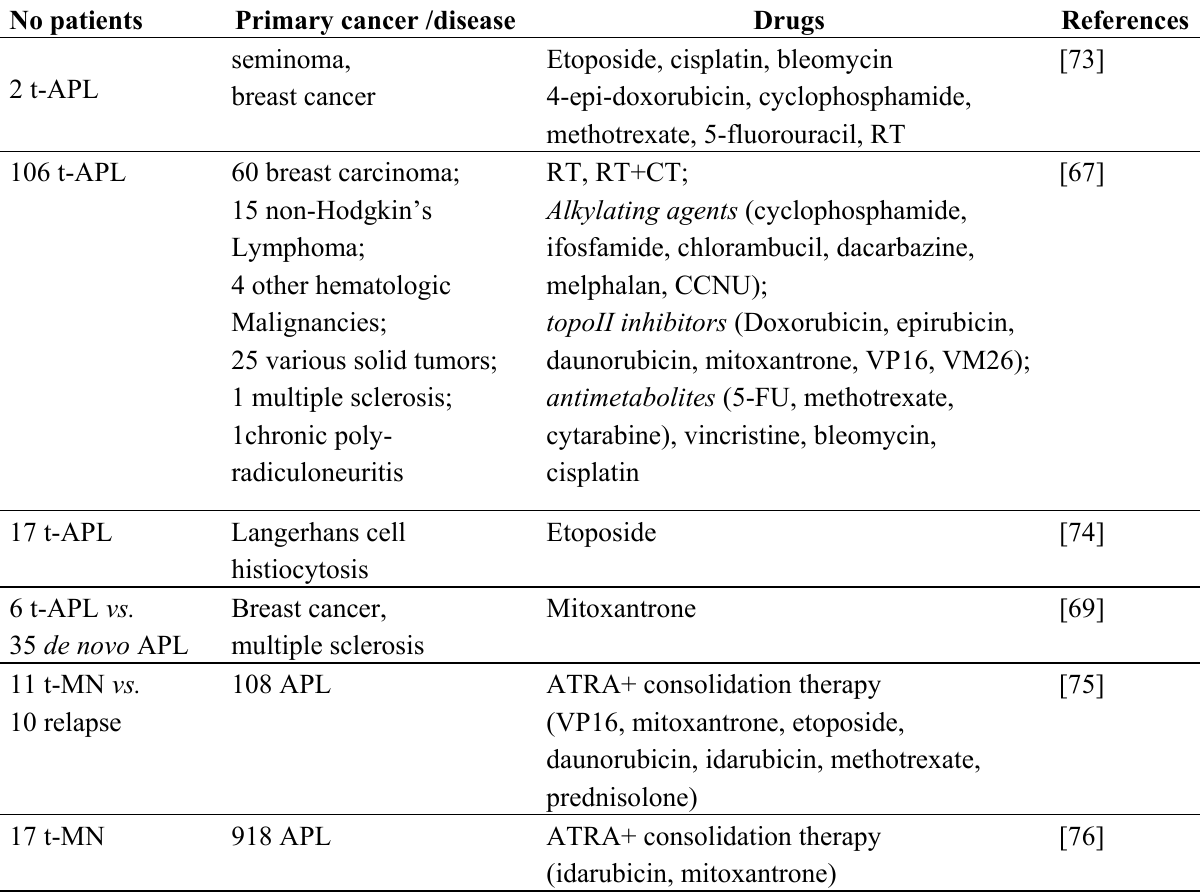
Table 4. Therapy-related APL and drugs for treating primary